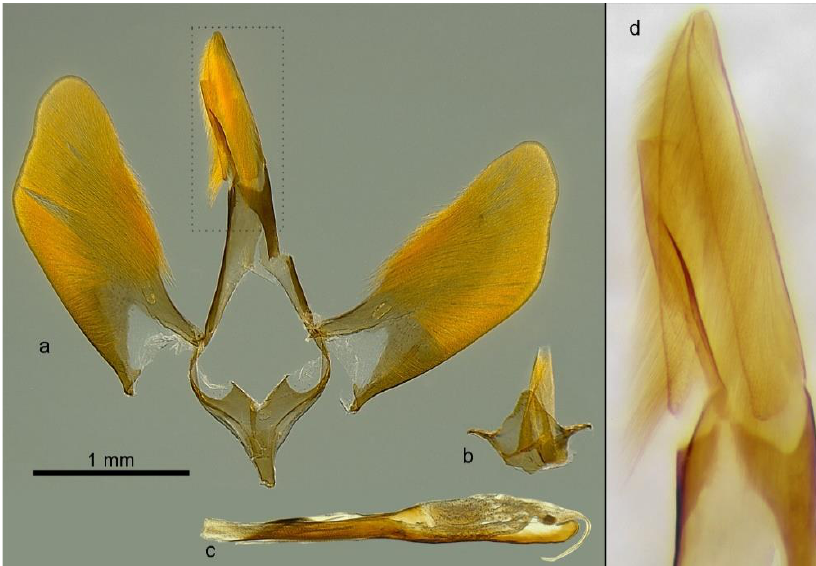
Figure 3. Male genitalia of Aurantiosphecia piotrii sp. nov. holotype. ( a ) Ventral view; ( b ) Juxta; ( c ) Aedeagus; ( d ) Details of uncus. Dotted frame marks enlarged area. Female unknown.